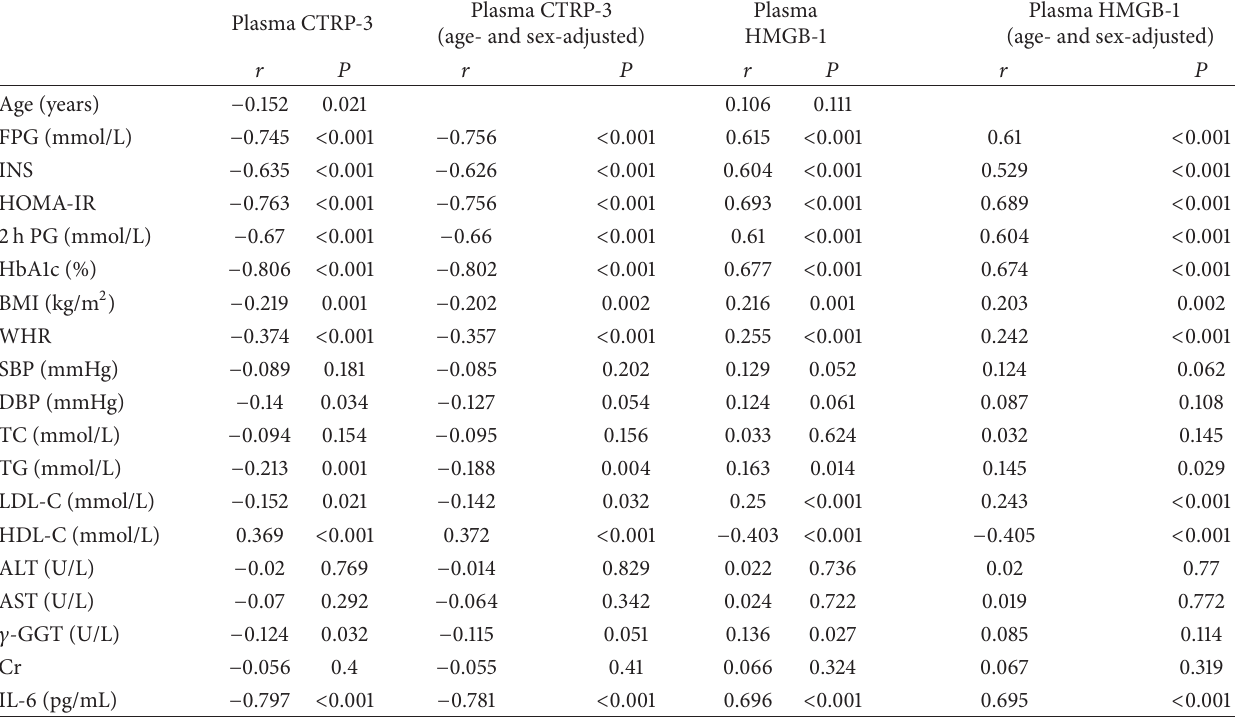
Table 2: Spearman and partial correlation analyses between variables and plasma CTRP-3 and HMGB-1.